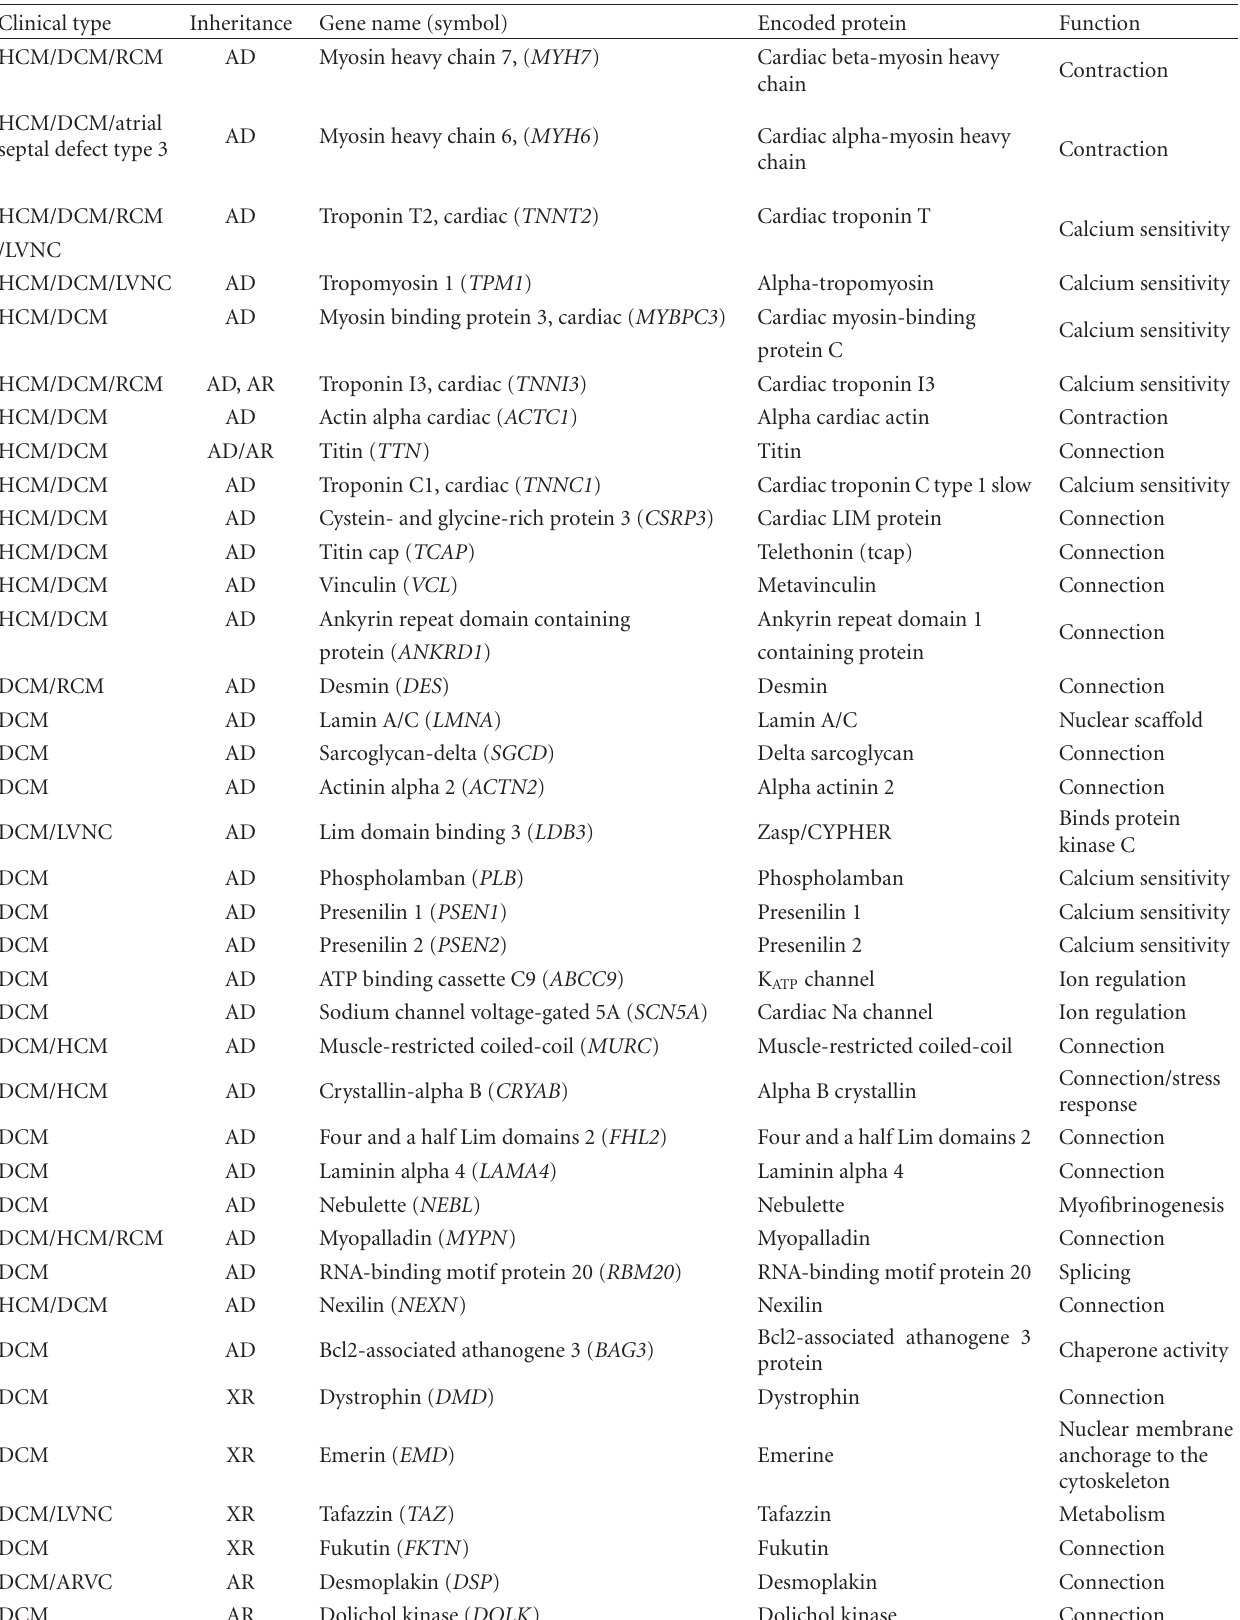
Table 1: Disease genes for primary